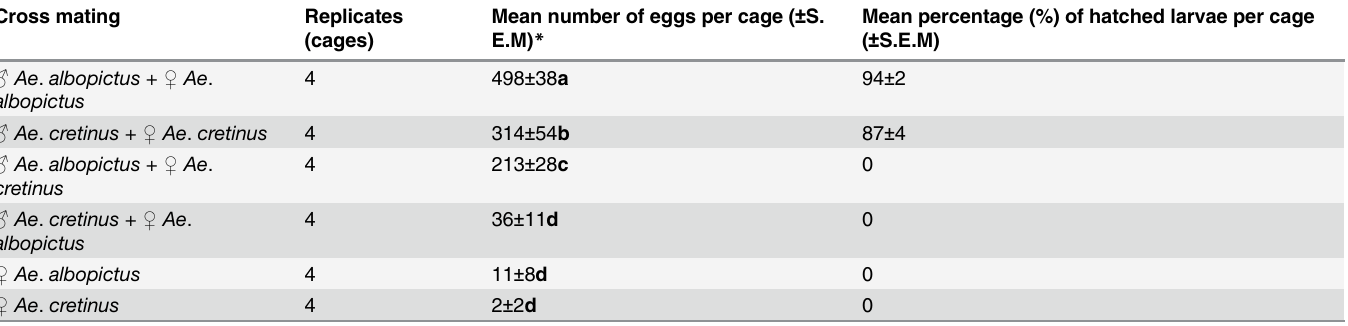
Table 1. Mean number of eggs ( ± S.E.M) and mean percentage of hatched larvae ( ± S.E.M) per cage of intra- and inter- specific non choice crosses of 20 virgin Ae . albopictus and Ae . cretinus males and females. Cross mating